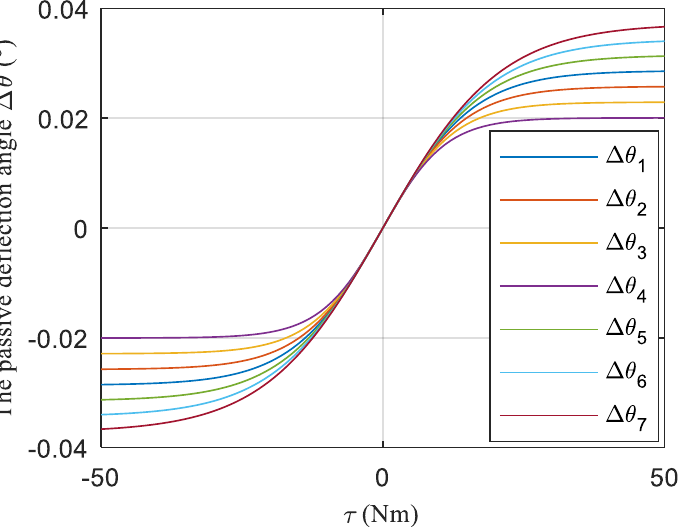
Figure 1. The relationship curve between the joint torque and the passive joint deflection